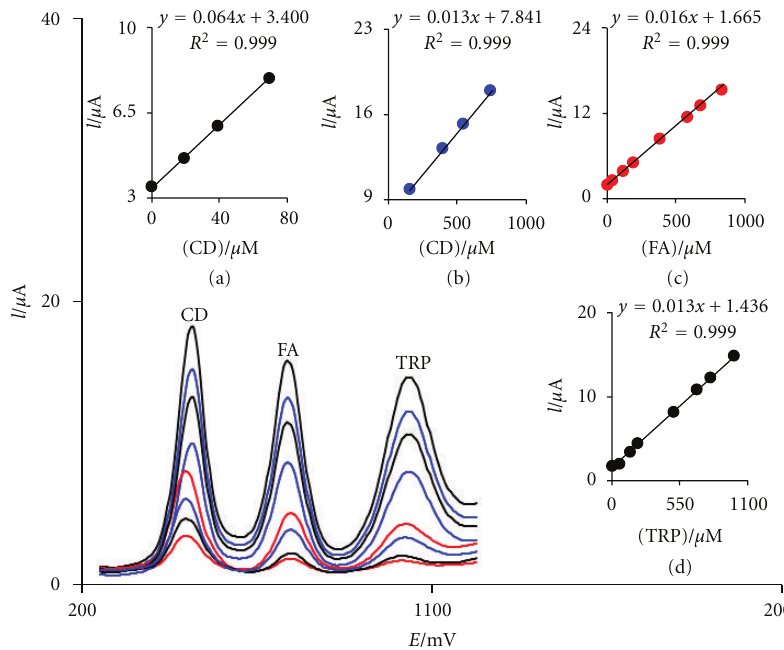
Figure 5: SWVs of FCDCNPE in 0.1 M PBS (pH 5.0) containing di ff erent concentrations of CD+FA+TRP in μ M, from inner to outer: 0.2 + 14.0+ 12.0, 20.0 + 50.0 + 40.0, 40.0 + 150.0 + 125.0, 70.0 + 200.0 + 200.0, 150.0 + 500.0 + 400.0, 400.0 + 700.0 + 600.0, 550.0 + 800.0 + 700.0, and 750.0 + 1000.0 + 850.0, respectively. Insets (a), (b), (c), and (d) are plots of I p versus CD, FA, and TRP concentrations,